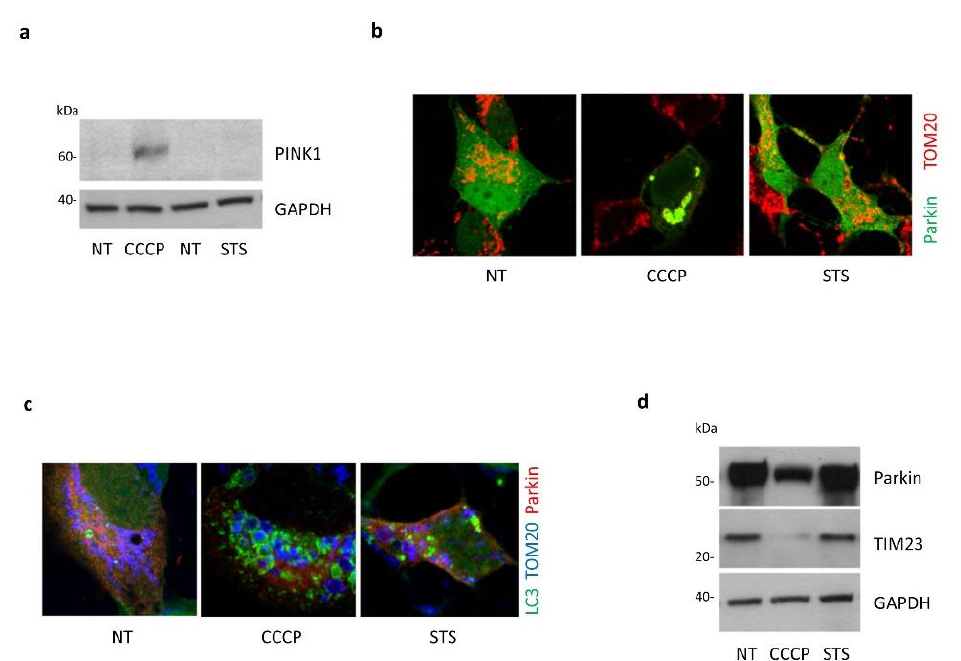
Figure 5. STS treatment does not induce PINK1 mediated mitophagy in SH-SY5Y cells. ( a ) SH-SY5Y cells were treated either with CCCP (360 min), STS (120 min) or vehicle (NT). Accumulation of endogenous PINK1 was only detected by Western blot after CCCP treatment, but not after STS treatment. Equal loading was verified by GAPDH protein levels; ( b ) Parkin-inducible SH-SY5Y cells were treated either with CCCP (360 min) or STS (120 min) and Parkin recruitment at mitochondria was assessed by confocal microscopy analysis. Parkin was immunostained with HA antibody (green); TOM-20 antibody was used to label the outer mitochondrial membrane (red). Parkin colocalized with TOM-20 only upon CCCP, whereas no colocalization was observed upon STS treatment; ( c ) colocalization of autophagosomes (LC3) and mitochondria (TOM-20). SH-SY5Y cells stably expressing GFP–LC3 were transiently transfected with Parkin-HA, treated with 360 min CCCP or 180 min STS and subjected to confocal microscopy analysis. Parkin and TOM-20 were immunostained in red and blue, respectively. Upon STS treatment, the number of cells with mitochon- dria engulfed into autophagosomes was significantly lower than in CCCP-treated cells; ( d ) mitoph- agy was also evaluated by assessing the expression of the mitochondrial marker TIM-23 by Western blotting, which significantly decreased only in Parkin-inducible SH-SY5Y cells treated with CCCP for 360 min. We observed no significant differences in TIM-23 levels upon STS for 360 min. Equal loading was verified by GAPDH protein levels. 3.5. STS-Induced Autophagy Is Regulated by PINK1 – Beclin1 Interaction In light of our previous findings showing activation of basal- and starvation-induced autophagy by PINK1 through its interaction with Beclin1 [21], we hypothesized that the same pathway could regulate autophagy induced by STS treatment. To test this hypothe- sis, we performed complementation experiments in SH-SY5Y cells depleted for PINK1 (shPINK1), by over-expressing PINK1 wild-type protein (WT) or two PD-associated path- ogenic mutants characterized by a different capacity to bind Beclin1 [21]. Strikingly, STS- induced autophagy was not affected by over-expressing the PINK1-G309D mutant that maintains the ability to interact with Beclin1 [21], as demonstrated by a similar LC3- II/LC3-I ratio in shPINK1 cells complemented with WT- or G309D-PINK1. Conversely,